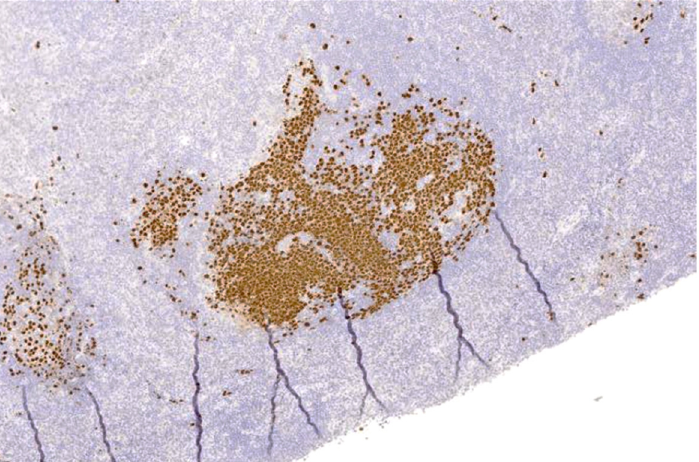
Figure 4. Germinotropic lymphoproliferative disorder . Immunohistochemical stain for KSHV/HHV8-encoded LANA shows co-infection of KSHV/HHV8 in the plasmablasts, within the nal